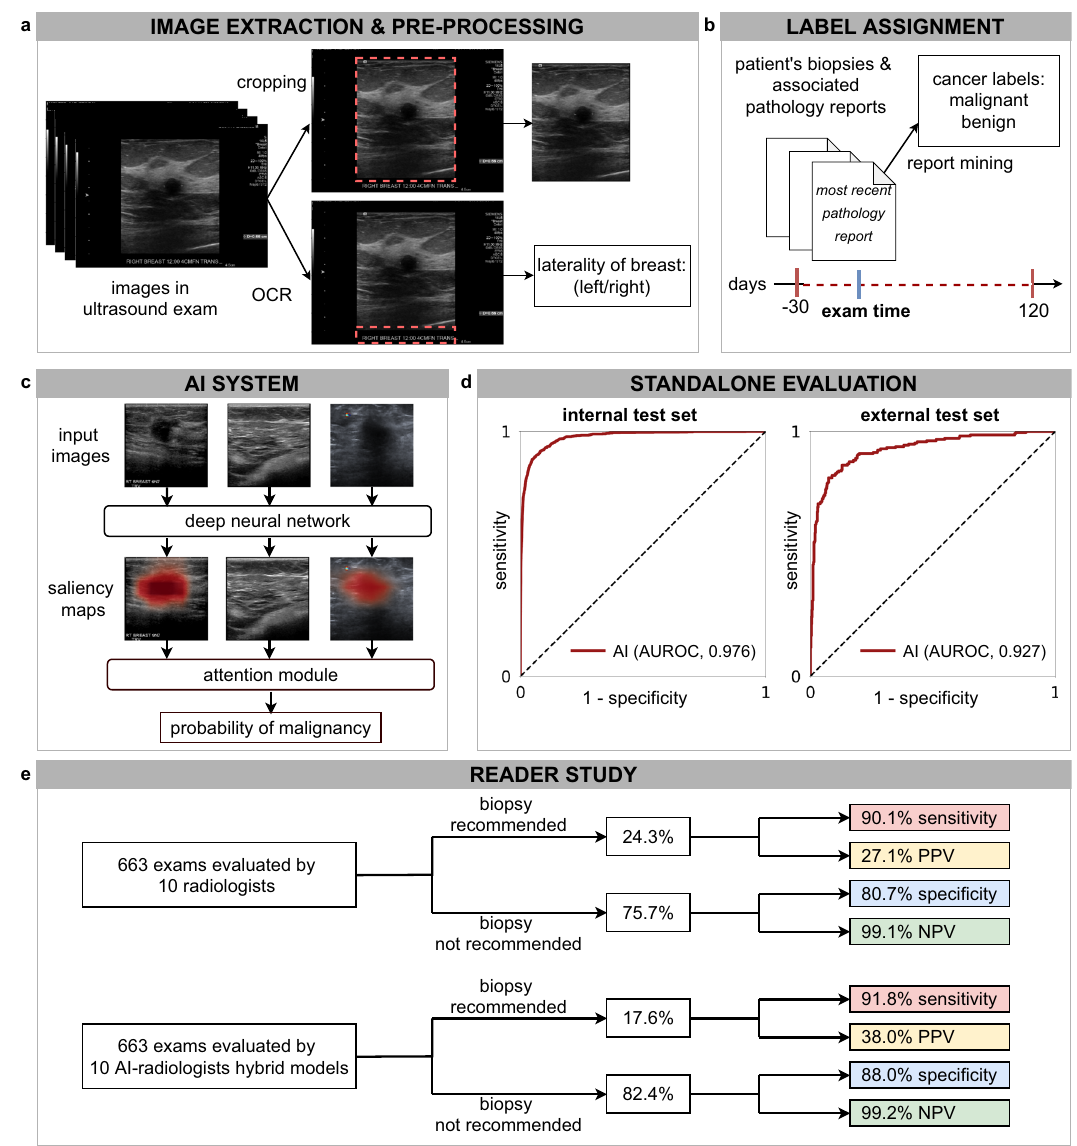
Fig. 1 Overview of the system ’ s pipeline. a US images were pre-processed to extract the breast laterality (i.e., left or right breast) and to include only the part of the image which shows the breast (cropping out the image periphery which typically contains textual metadeta about the patient and US acquisition technique). b For each breast, we assigned a cancer label using the recorded pathology reports for the respective patient within − 30 and 120 days from the time of the US examination. We applied additional fi ltering on the internal test set to ensure that cancers in positive exams are visible in the US images and negative exams have at least one cancer-negative follow-up (see Methods section `Additional fi ltering of the test'). c The AI system processes all US images acquired from one breast to compute probabilistic predictions for the presence of malignant lesions. The AI system also generates saliency maps that indicate the informative regions in each image. d We evaluated the system on an internal test set (AUROC: 0.976, 95% CI: 0.972, 0.980, n = 79,156 breasts) and an external test set (AUROC: 0.927, 95% CI: 0.907, 0.959, n = 780 images). e In a reader study consisting of 663 exams ( n = 1024 breasts), we showed that the AI system can improve the speci fi city and positive predictive value (PPV) for 10 attending radiologists while maintaining the same level of sensitivity and negative predictive value